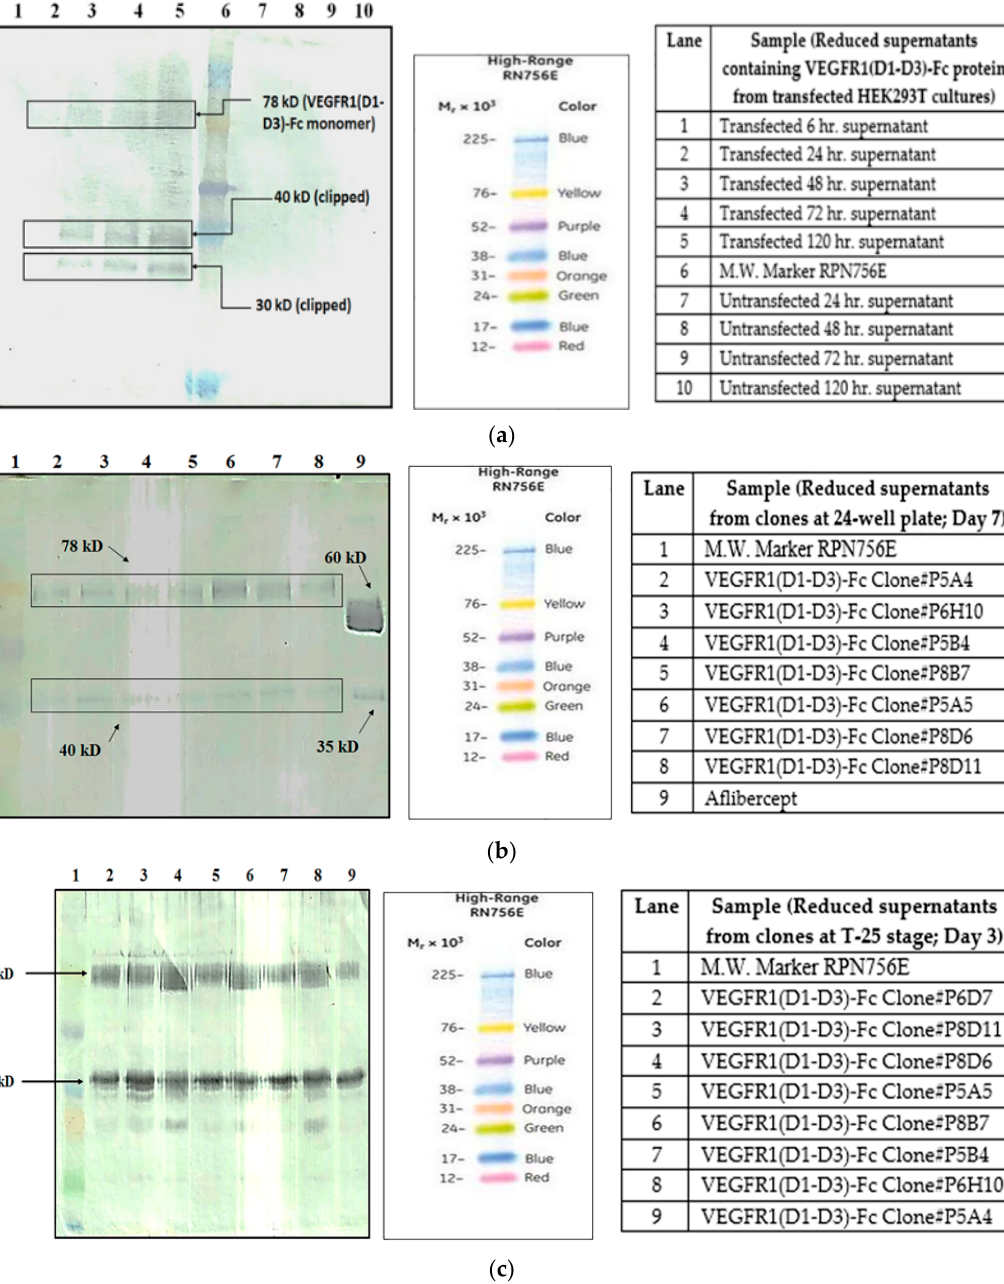
Figure 1. Cont. Figure 1.